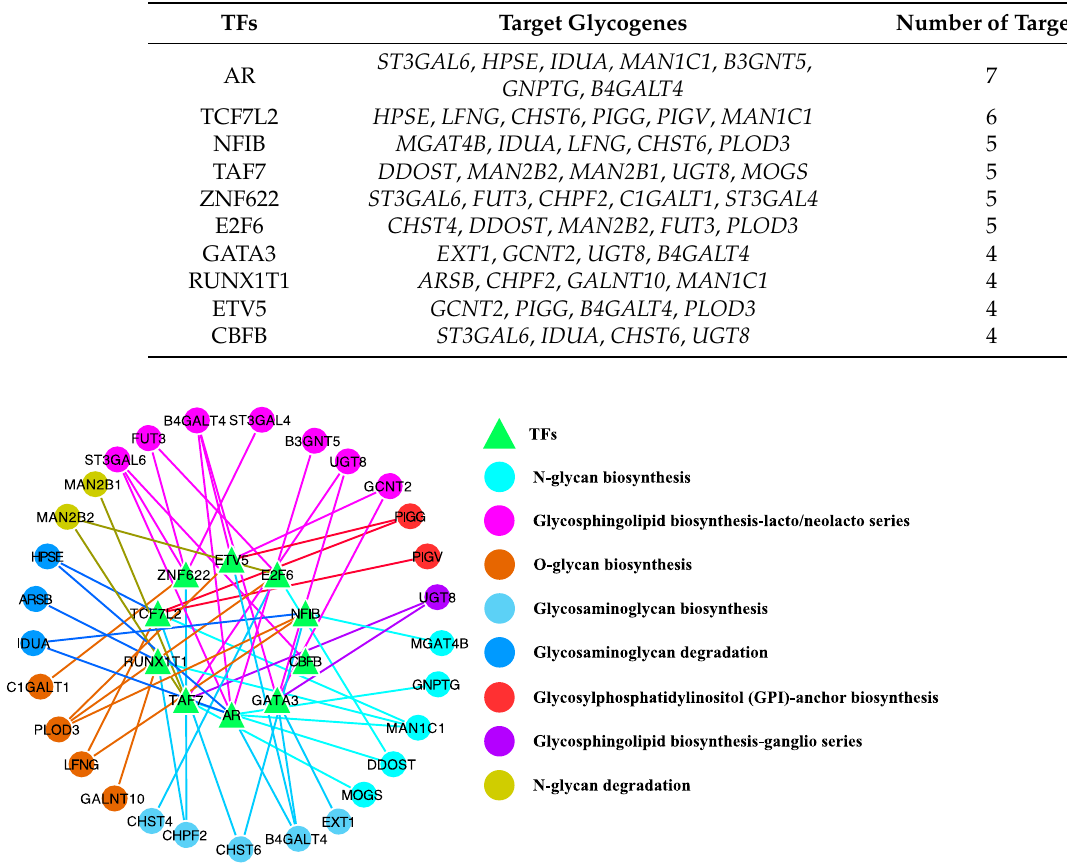
Table 1. Candidate transcription factors (TFs) with corresponding target-TNBC-specific glycogenes.